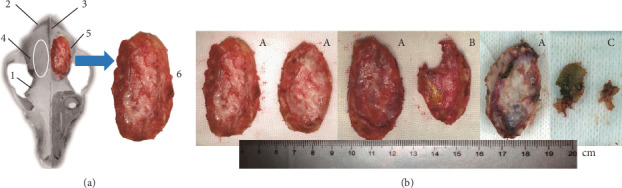
Schematic diagram and evaluation quality for the harvesting of dog cranial flap. (a) Schematic diagram for the removal of the dog cranial flap. 1: temporal line; 2: occipitoparietal suture; 3: external sagittal crest; 4: the model of the removed cranial flap; 5: cranial flap to be harvested; 6: enlarged picture of harvested cranial flap. (b) Evaluation of bone graft appearance quality: grade A, relatively complete with even thickness; grade B, incomplete with defect area ≤ 30%; grade C, defect area > 30%.